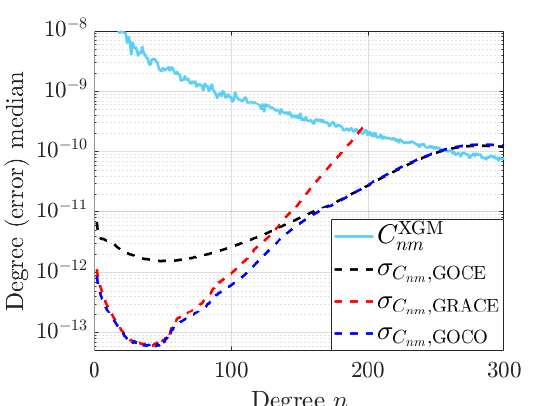
Figure 1. Medians of the standard deviations of the SH coefficients for each SH degree n , for static gravity field models derived from Gravity field and steady-state Ocean Circulation Explorer (GOCE) data (the GO_CONS_GCF_2_TIM_R6 model [4], black curve), Gravity Recovery and Climate Experiment (GRACE) data (the ITSG-Grace2018s model [8], red curve), and a combination of various satellite data including GOCE and GRACE (the GOCO06s model [9], dark blue curve), respectively. For comparison, the degree medians of the gravitational signal given by the SH coefficients of the combination model XGM2019e_2159 [10] are shown by the light blue curve. The representation of the signal and error levels by degree (error) medians instead of degree (error) variances was chosen in order to avoid a major impact of the less constrained polar gap wedge SH coefficients in the GOCE